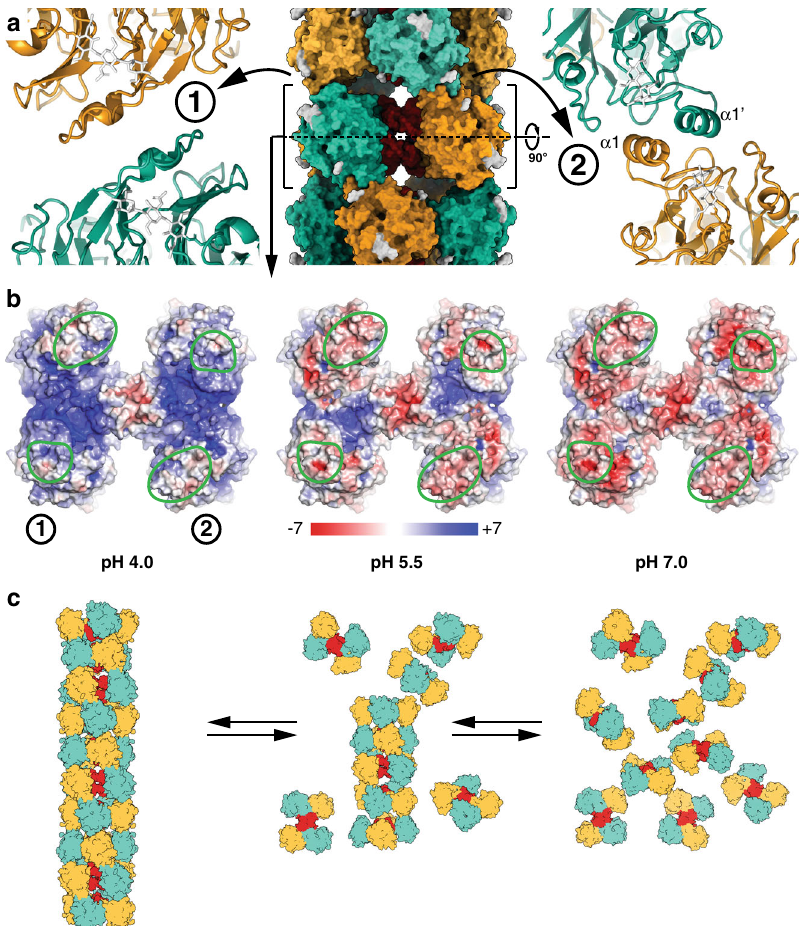
Fig. 2 The pH-dependent disassembly of RJ fi laments. a At pH 4.0, two major interfaces (labeled 1 and 2) between symmetry-related hetero-octamers exist in the RJ fi lament. Subunits (shown as surface in the overview and cartoons in the close-ups) are colored as in Fig. 1. The major contact (label 2) is mediated by homodimerization of MRJP1 alpha helices 1 ( α 1). b Top views of the electrostatic surface potentials (± 7 kT/e) of one hetero-octameric layer calculated at different pH values (see Methods for details). At pH 4.0, the four contact areas (1606Å 2 in total) between the hetero-octamer layers (encircled in green) are predominantly hydrophobic and allow stable assembly of the hetero-octamers into RJ fi laments. At the higher pH values observed in the gut of bee larvae, the interaction sites become negatively charged. The repulsion between the hetero-octamer layers leads to destabilization and eventually disassembly of the RJ fi lament. c Schematics showing the pH-dependent assembly model of RJ fi